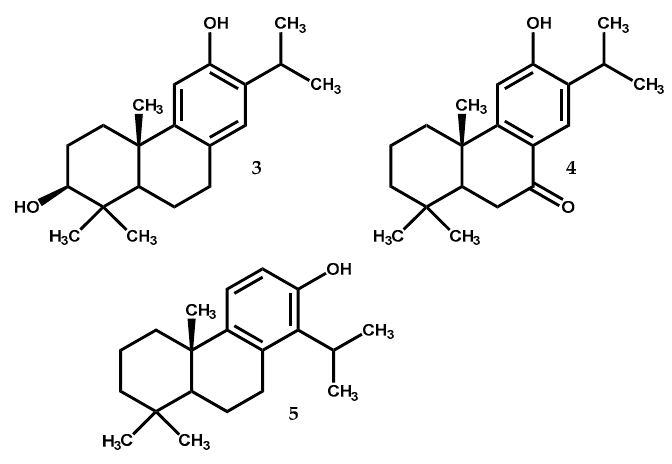
Figure 3. Diterpenes ( 3–5 ) from Juniperus species with significant pharmacological potential.